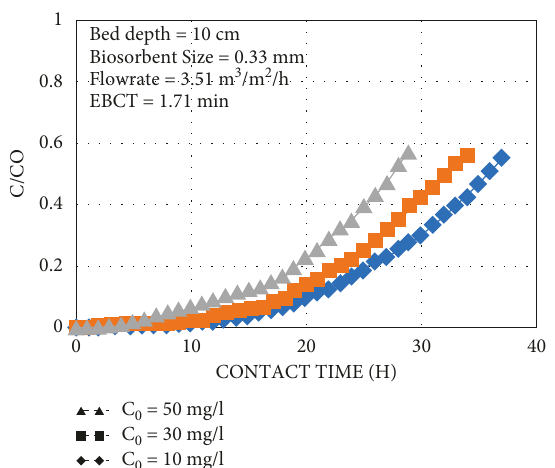
Figure 4: Effect of initial sorbate concentration.